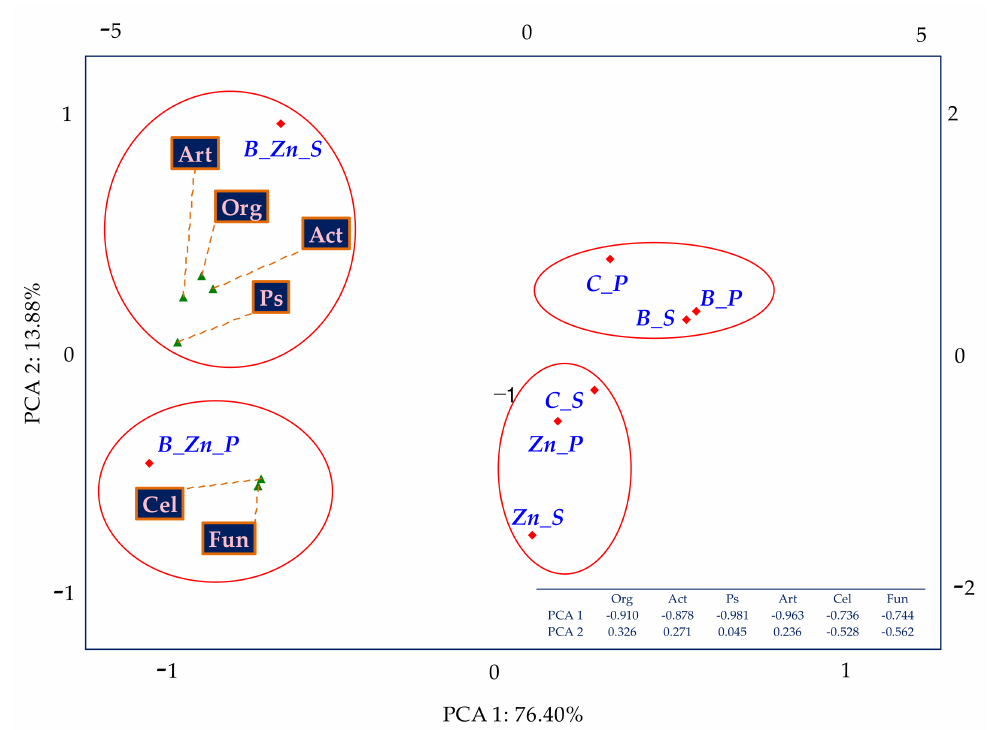
Figure 7. The coefficient of the influence of plants (IF P ) on the number of organotrophic bacteria (Org), actinomycetes (Act), fungi (Fun), Pseudomonas sp. (Ps), Arthrobacter sp. (Art), and cellulolytic bacteria (Cel) in the soil contaminated with B, Zn 2+ , and B + Zn 2+ —PCA method; S— Sorghum Moench ; P— Panicum virgatum ; C—uncontaminated soil; B—bisphenol A; Zn—ion zinc (Zn 2+